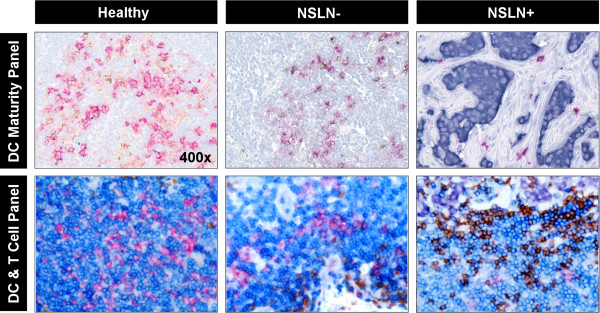
High-resolution IHC Images of DC Clusters in two staining panels. Immunohistochemistry stained images of DC clusters from healthy, NSLN- and NSLN+ patient samples, serially stained in both a DC maturity assessment panel and a T cell colocalization panel. Stains for the maturity panel include: Red (CD1a, Immature DCs), Brown (CD83, Mature DCs), Blue (Hematoxylin, Non-DC cells). Stains for the T cell colocalization panel include: Magenta (CD1a, Immature DCs), Dark Blue (CD3, T cells), Brown (CD20, B cells), Light Blue (Hematoxylin, other cells). The dark purple cells in both panels are pan-cytokeratin-stained tumor cells. All images were taken at 400× resolution.